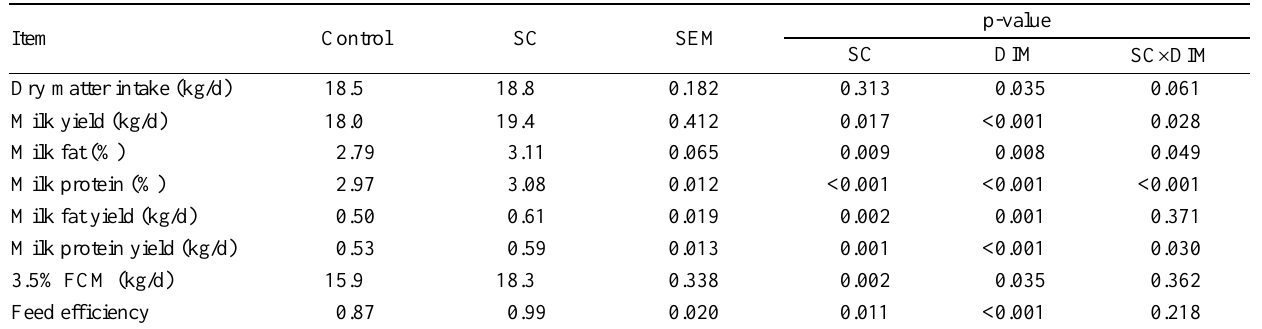
Table 4. Effect of yeast culture supplementation (SC) 1 on milk yield and milk composition on Farm 2 Item